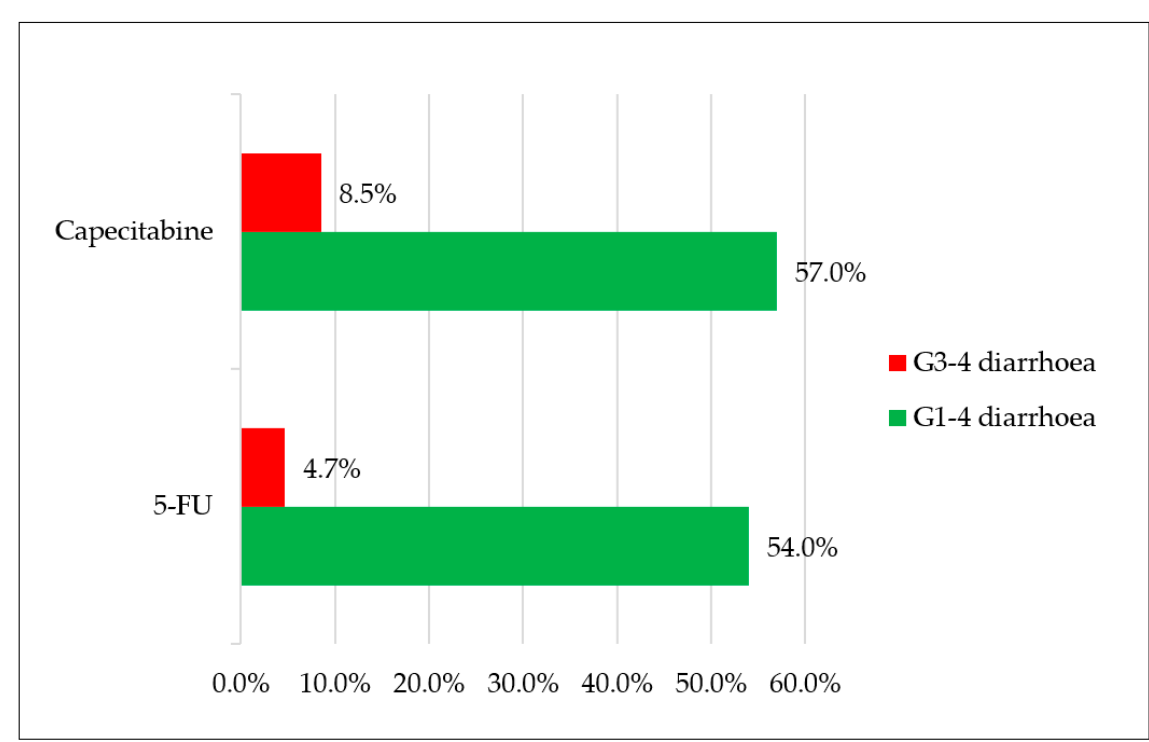
Figure 2. Percentage of patients with G1–4 diarrhoea and G3–4 diarrhoea receiving chemotherapy treatment with capecitabine or 5-fluorouracil (5-FU).